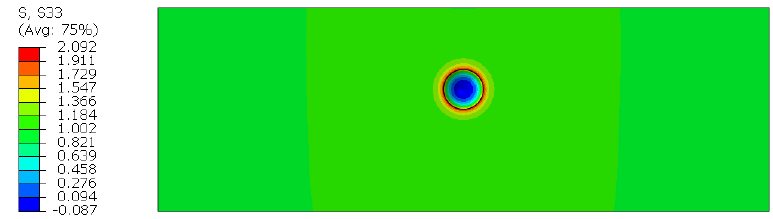
Figure 12. Numerically computed axial stress S33 for spherical gas pore.